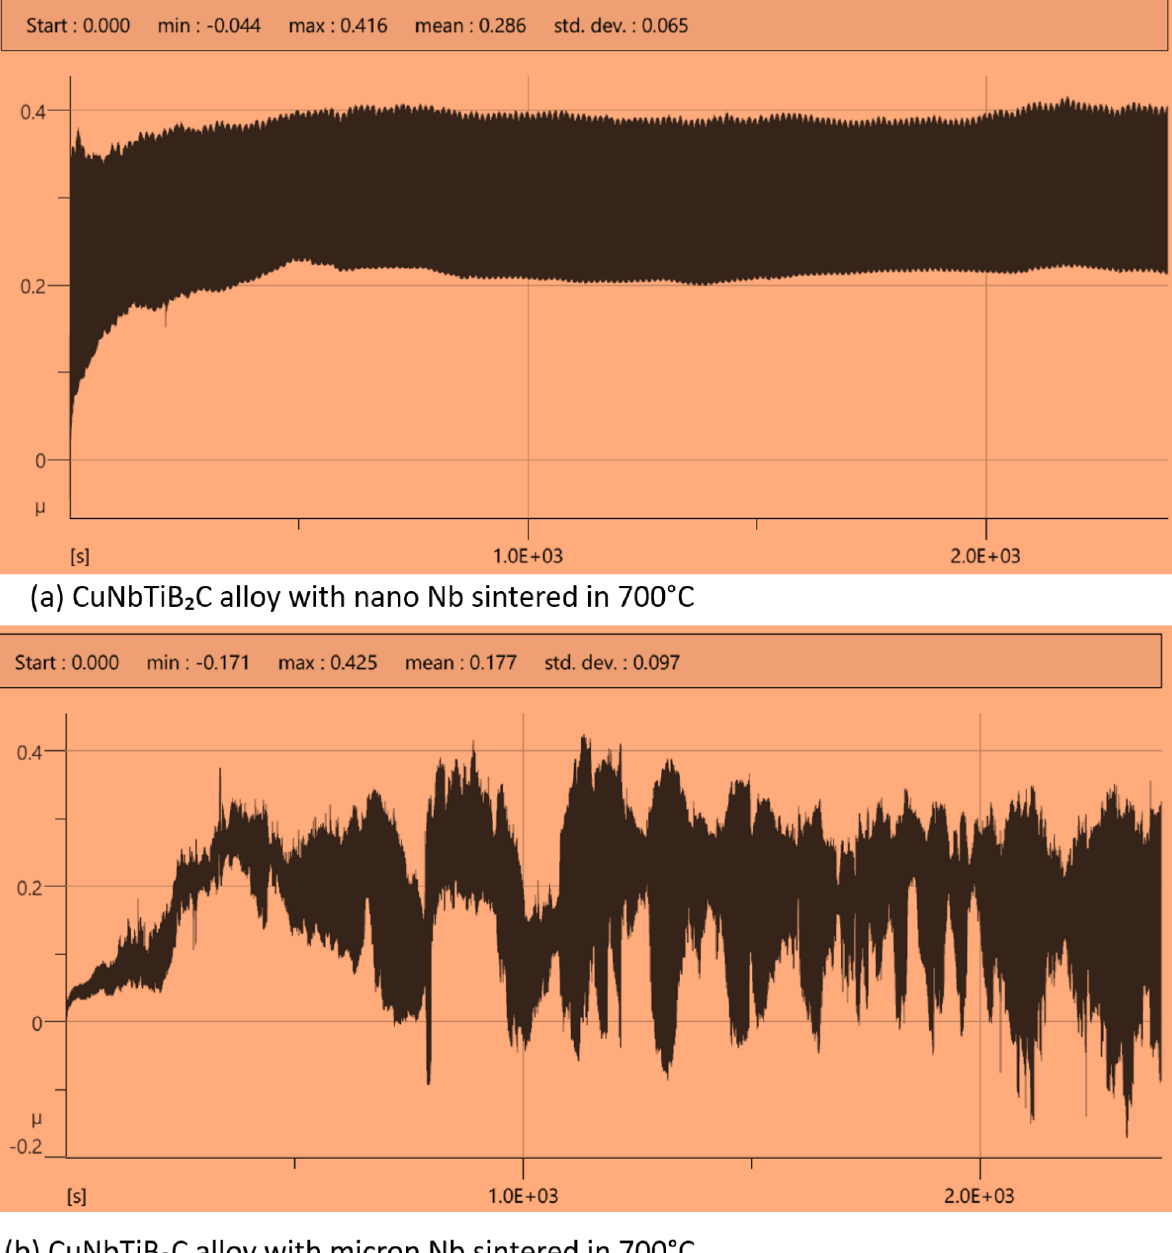
Figure 7. ( a ) and ( b ) compare the graph of the coefficient of friction versus time of CuNbTiB 2 C alloys with nano and micron both sintered at 700